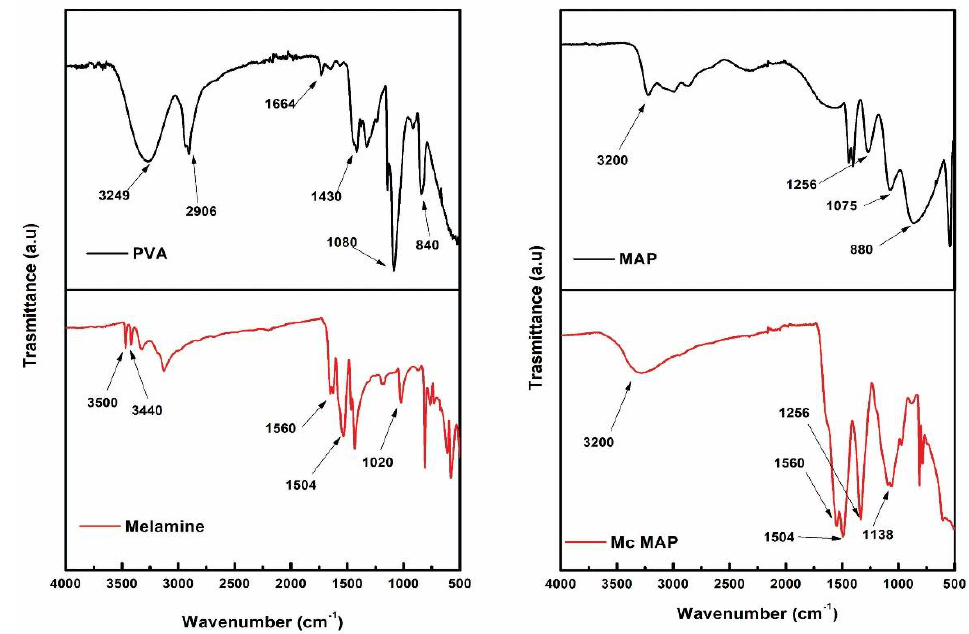
Figure 1. Fourier Transform Infrared Spectroscopy (FTIR) spectra of the microencapsulation of dihydrogen ammonium phosphate (MAP)